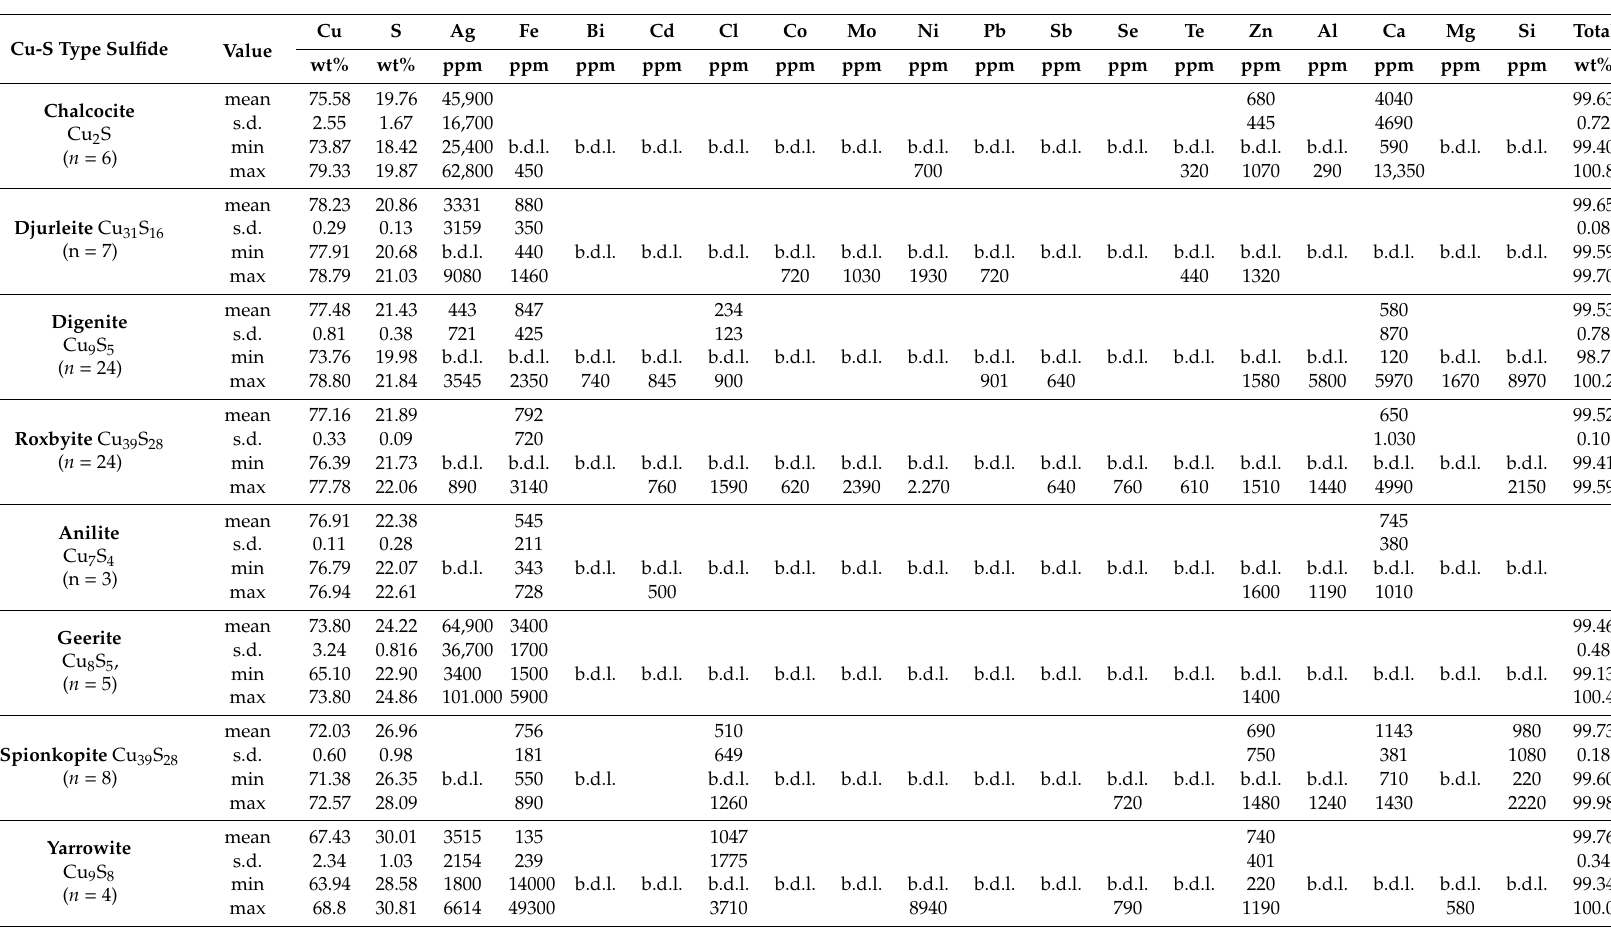
Table 9. Chemical composition of Cu-S-type sulfides from the Cu-Ag Kupferschiefer deposits on the Fore-Sudetic Monocline identified by EPMA. Cu-S Type